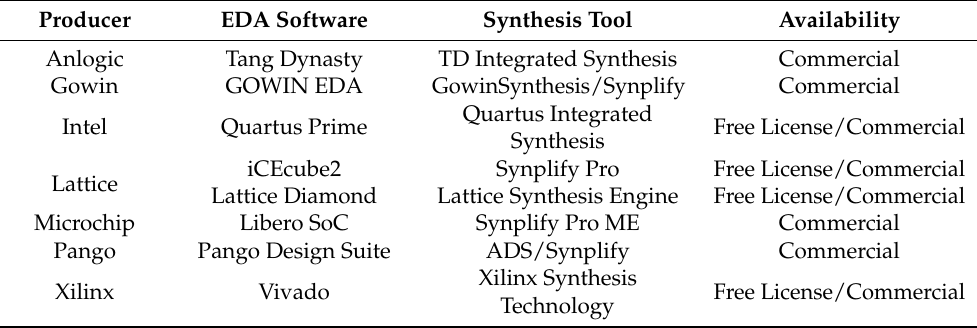
Table 5. The specification of EDA